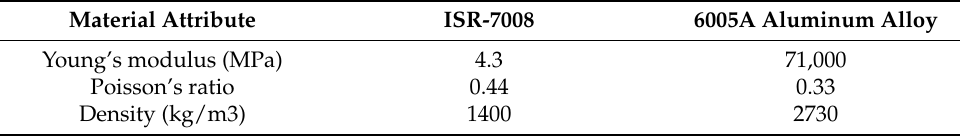
Table 1. Mechanical property parameters of adhesive and adhesive substrate.